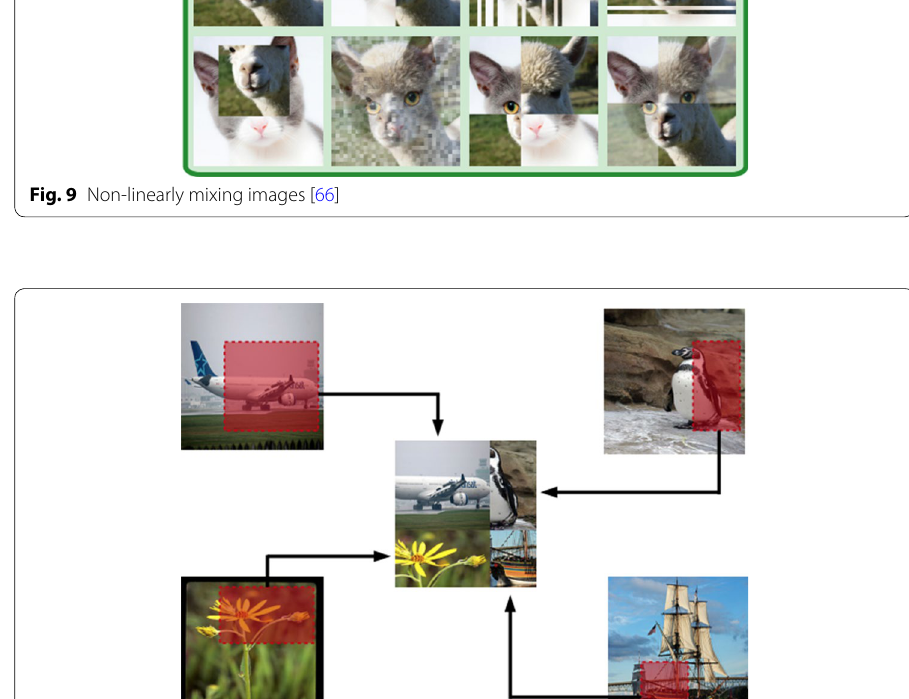
Fig. 10 Mixing images through random image cropping and patching